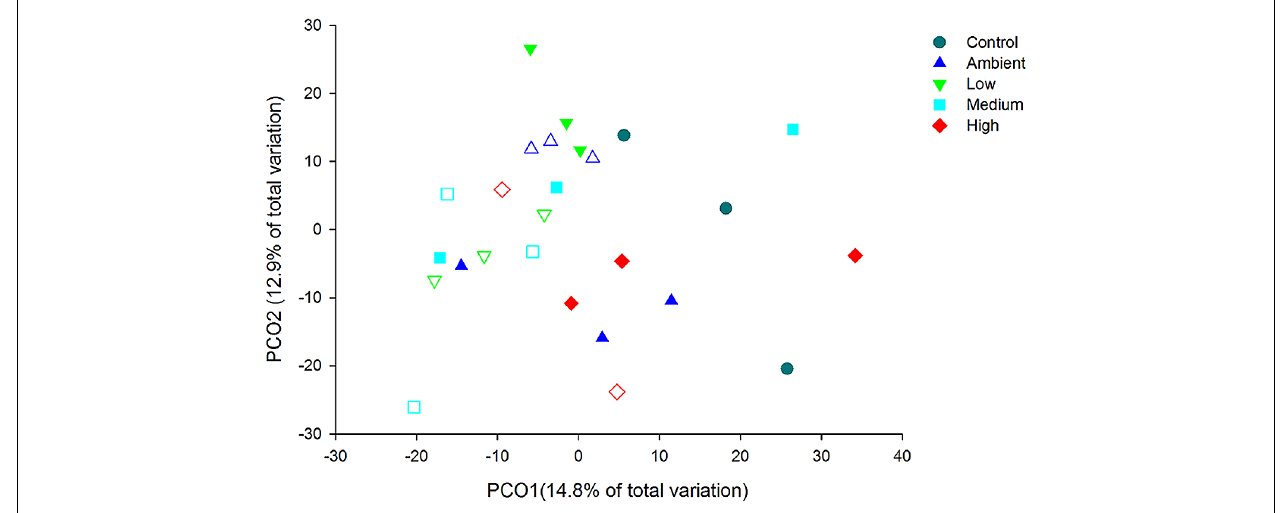
FIGURE 6 | PCO of the OTUs from the RNA-derived samples. Control samples are from day 0, solid symbols represent day 2 samples and open symbols represent day 7 samples.